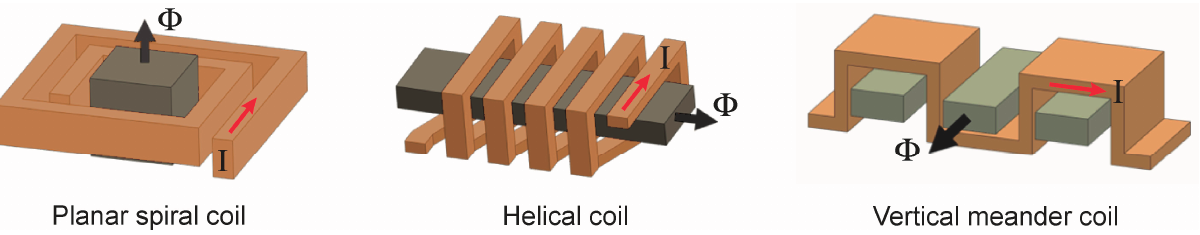
Figure 2. Typical designs of microcoils applied in magnetic micromotors (according to [18], Φ : magnetic flux, I : electric current).